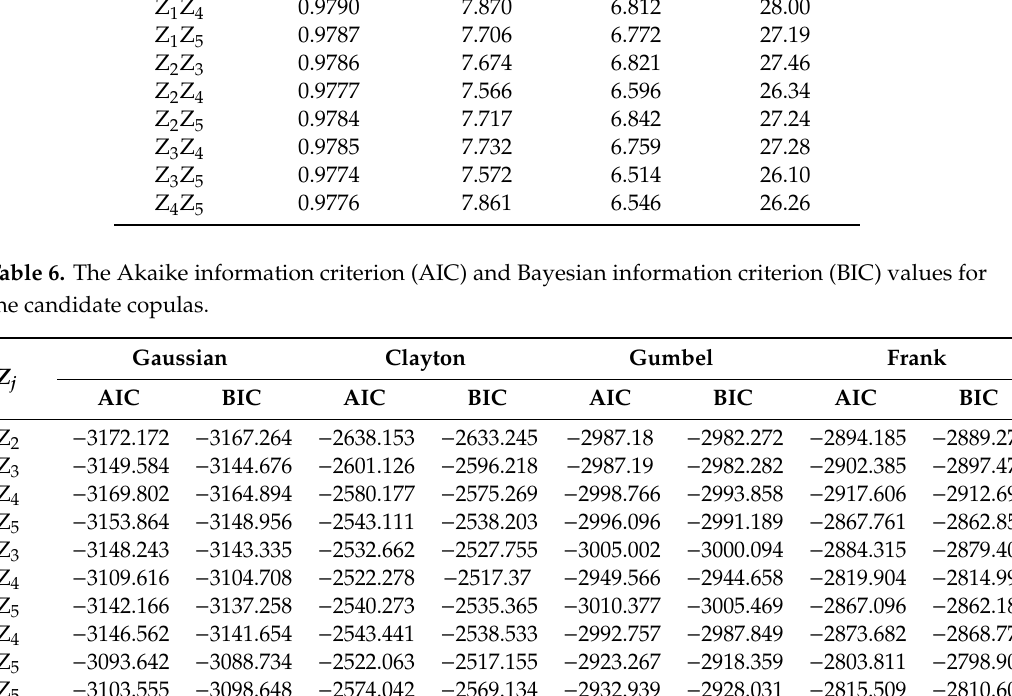
Table 7. The joint failure probability of each pair of failure modes based on a Gaussian copula.